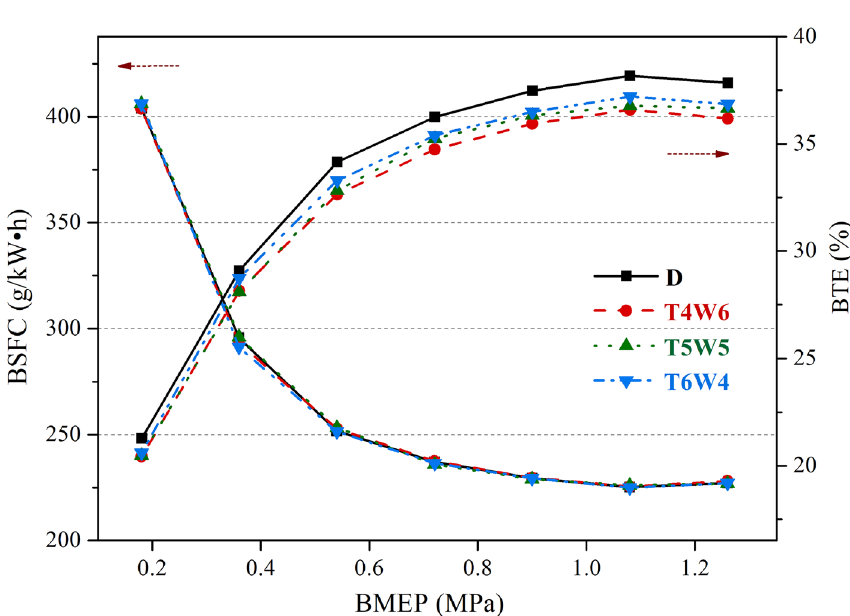
Figure 3. Fuel economies of three kinds of coal-based diesel blends and petroleum